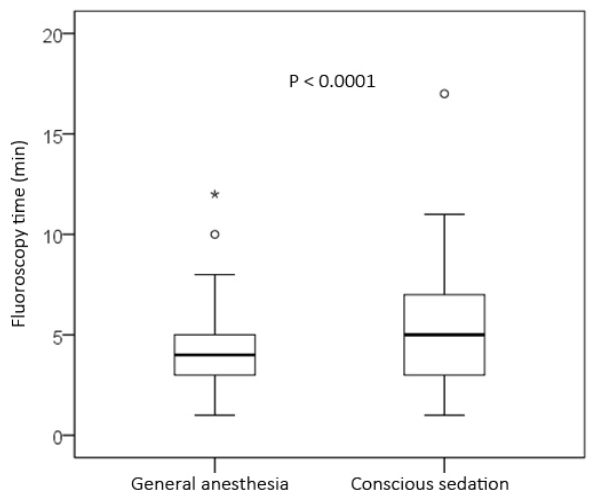
Fig. 4. Fluoroscopy time.